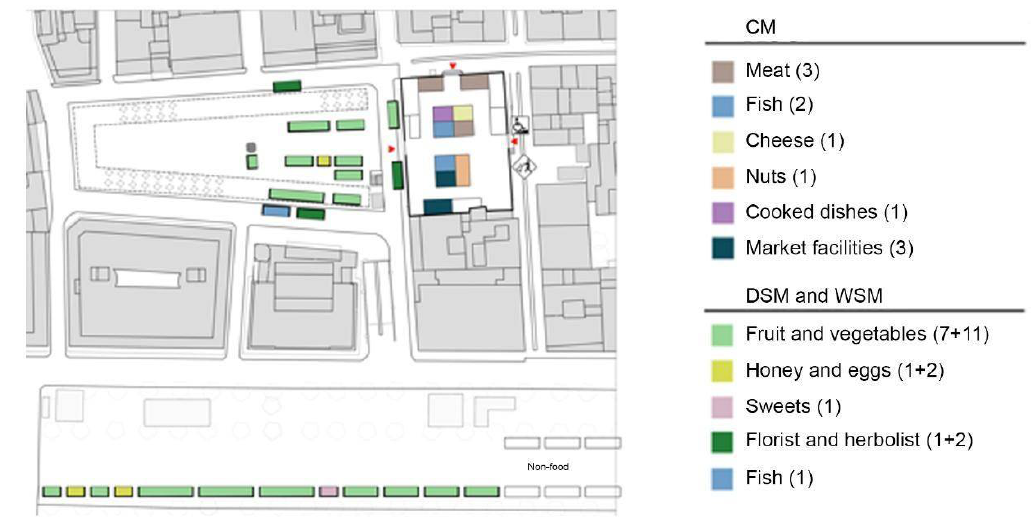
Figure 3. The Sant Feliu de Guíxols system of three markets. Source: Maximiliano Monsalvo González, Joaquim Perea i León.